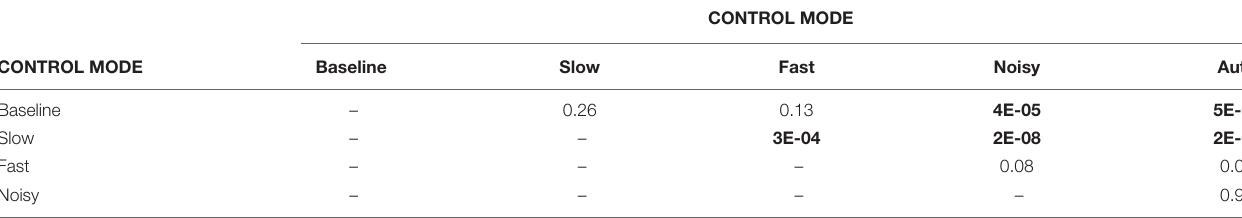
TABLE 3B | Post hoc comparisons ( p -values) for implicit agency across control modes on rigid surface.